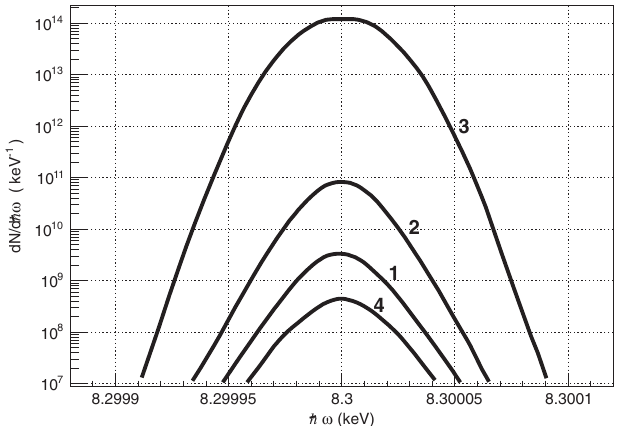
FIG. 2. Spectral distributions of CXBR, CXTR, CXRTR, and CXDR (curves 1, 2, 3, and 4, respectively).